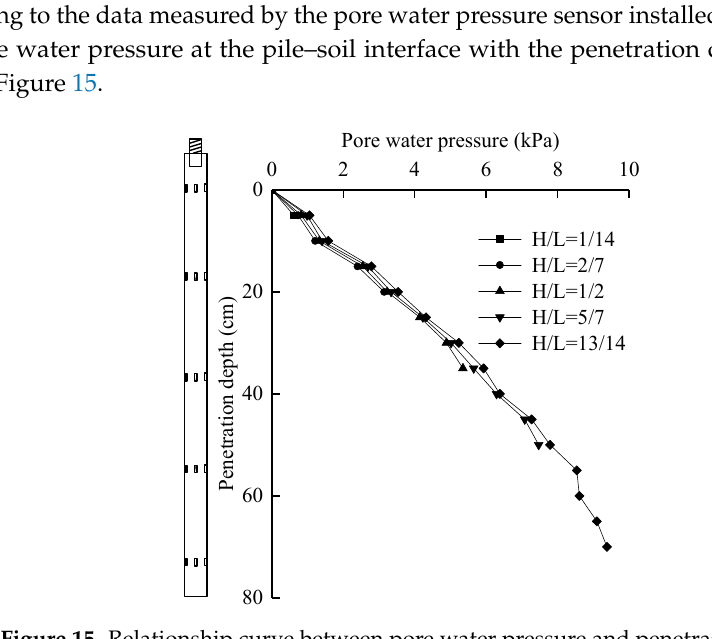
Figure 15. Relationship curve between pore water pressure and penetration depth.